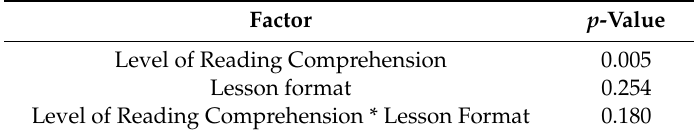
Table 4. ANOVA on number of correct marks with respect to level of reading comprehension and lesson